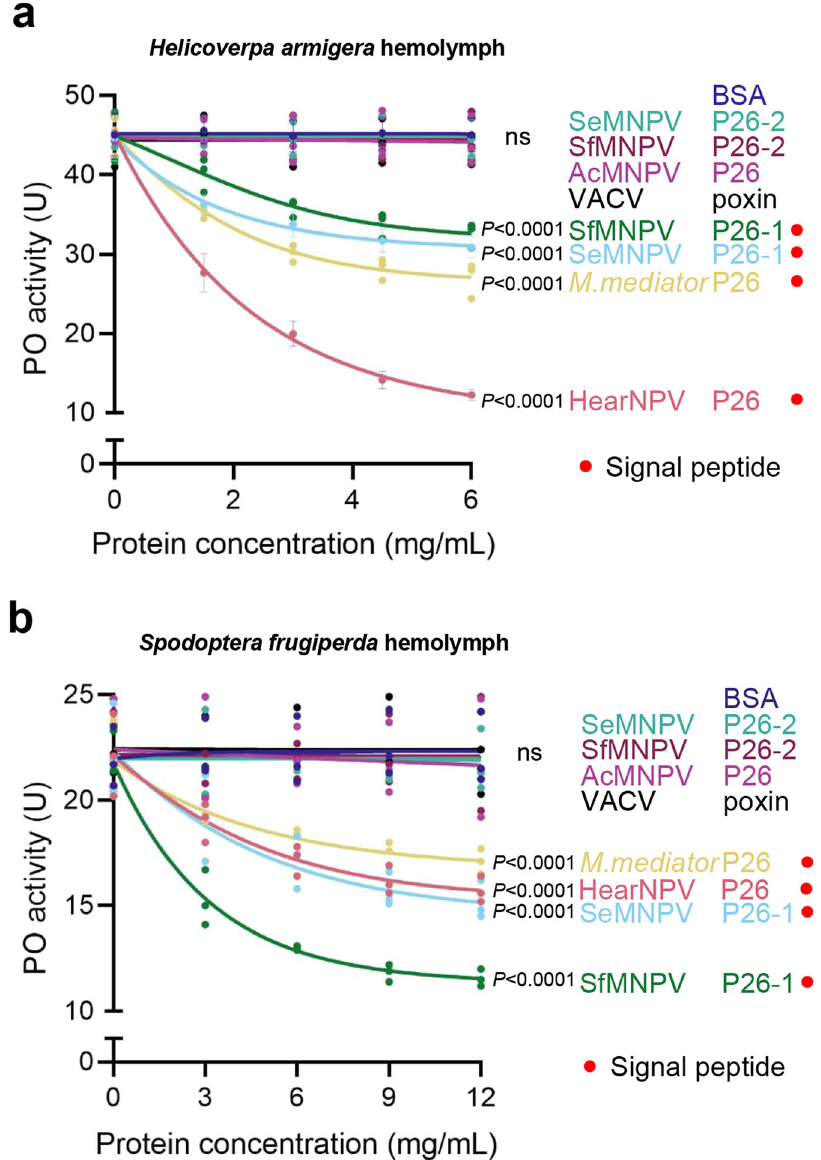
Fig. 6 | Secreted P26 homologs from different sources evolved the function of suppressing PPO activation. One μ L hemolymph from naïve third instar H. armigera ( a )orfourthinstar S.frugiperda ( b )weremixedwithdifferentamountsof indicated P26/poxin and incubated on ice for 30min before PO activity assay. BSA was used as a negative control. All data are representative of three independent experiments. Statistical signi fi cance of differences between the negative control BSA and recombinant proteins were evaluated via two-way ANOVA. a BSA vs. SfMNPV P26 - 1: P <0.0001, BSA vs. SeMNPV P26-1: P <0.0001, BSA vs. M.